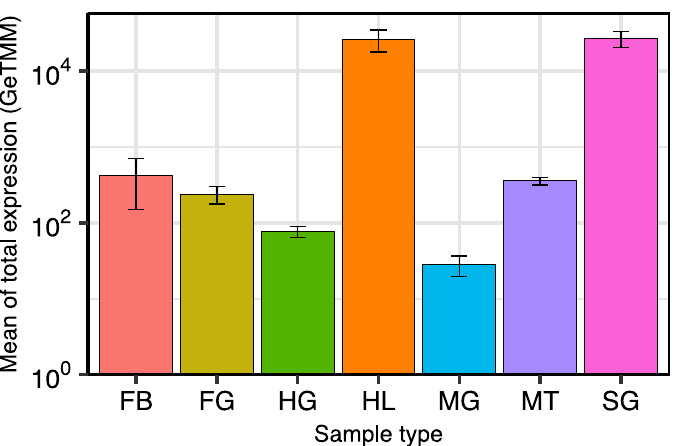
Figure 2. Total normalized expression (GeTMM) of AMP genes in seven sample types of B. germanica . Values are the means of expression of all AMP genes in each sample type. Graph bars are standard deviations. Abbreviations: FB (fat body), FG (foregut), HG (hindgut), HL (hemolymph), MG (midgut), MT (Malpighian tubules) and SG (salivary glands). Y-axis is in log scale.